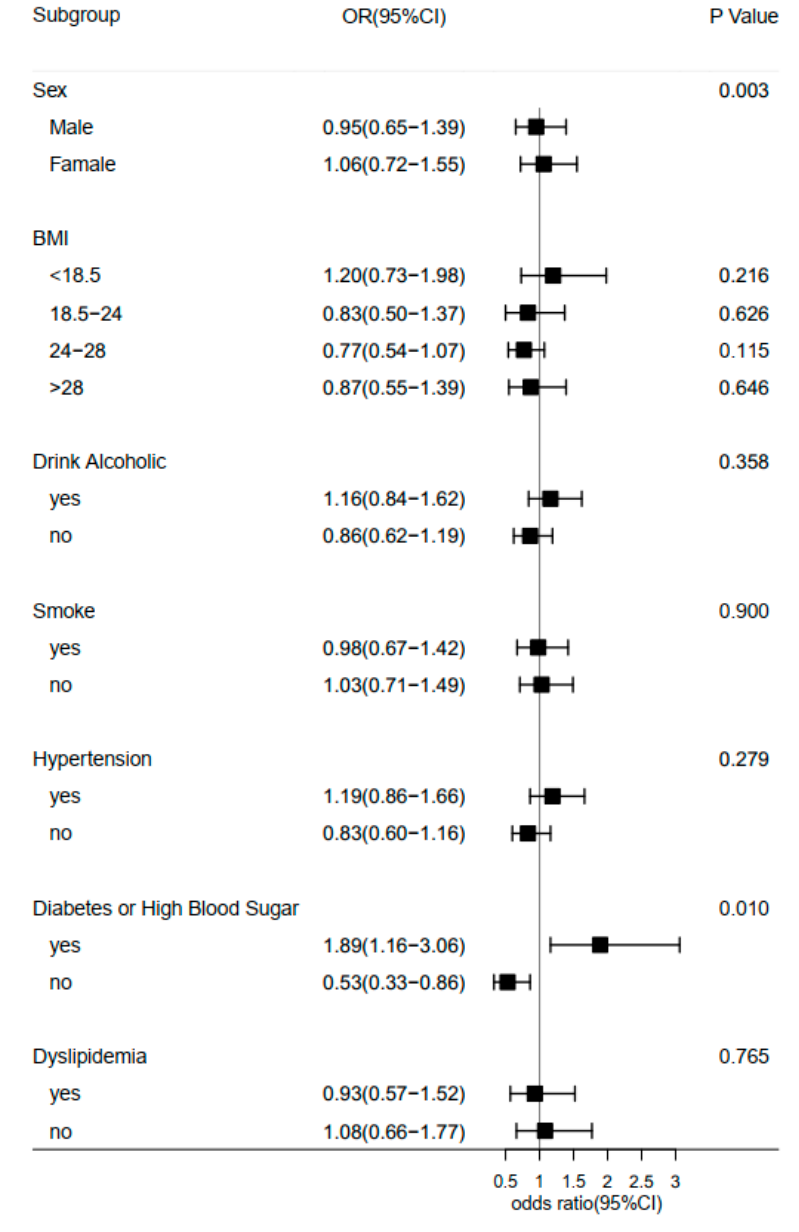
Figure 4. Forest plot of logistic regression analysis of midday napping and risk of hip fracture stratified by baseline information.